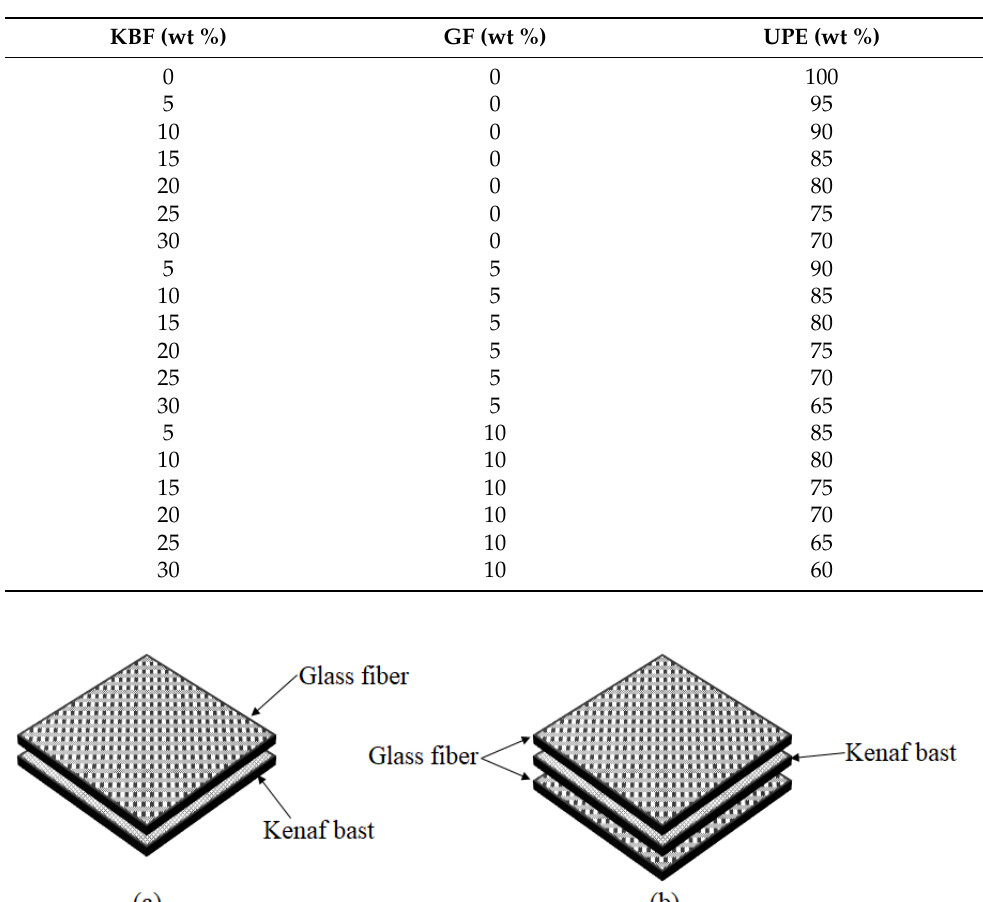
Table 2. Composition of hybrid KBF/GF-reinforced UPE composites.